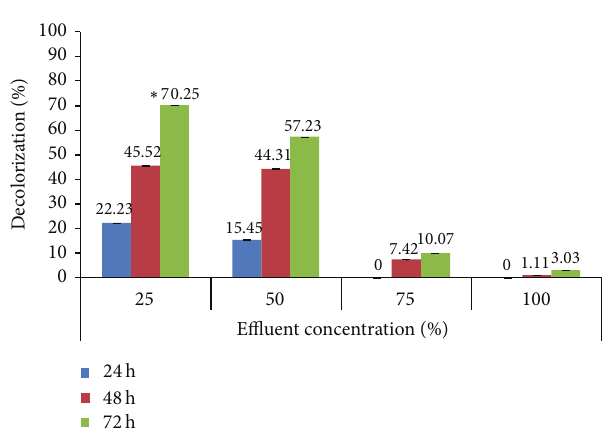
Figure 3: Effect of pH on decolorization.